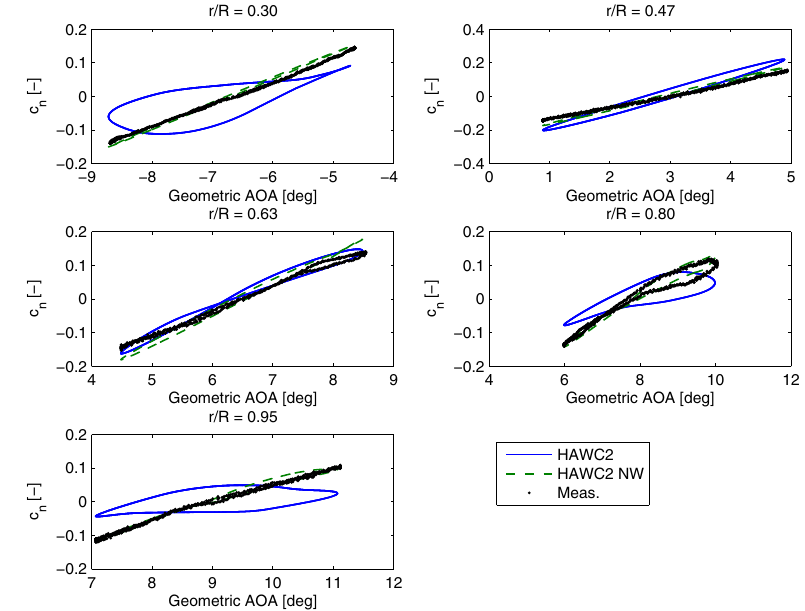
Figure 6. Case O47010. Variation about mean c n